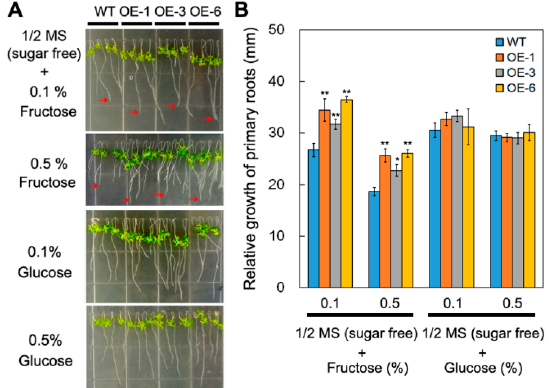
Figure 5. Relative root growth of wild type (WT) and DsSWEET17 transgenic Arabidopsis seedlings on different sugar (fructose and glucose) sources. Seedling ( A ) and relative root growth ( B ) of WT and three transgenic lines on 1/2 MS medium (sucrose free) containing different concentrations of fructose (0.1% and 0.5%) or glucose (0.1% and 0.5%). The red arrow indicates the root tip. Asterisks indicate significant differences between WT and transgenic lines (* p < 0.05; ** p < 0.01; Student’s t test). Error bars show the SD of the values from three replicates.